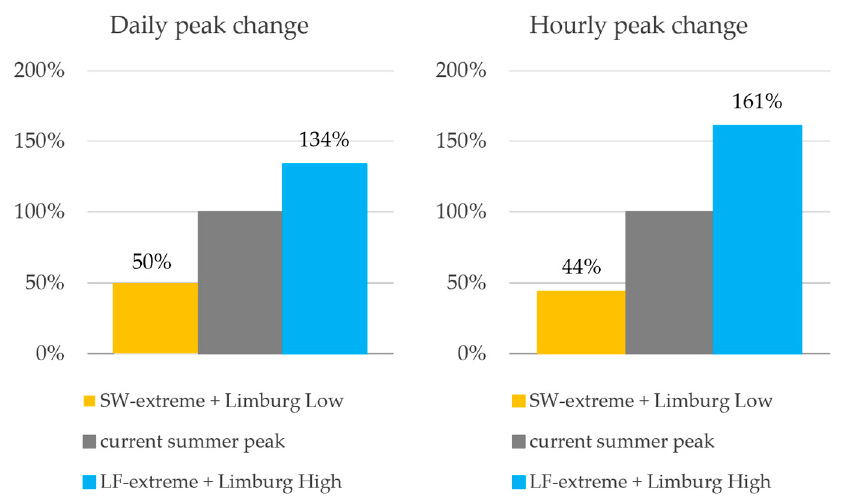
Figure 8. Change in summer day peak ( left ) and hour peak ( right ) in relation to current peak demands (100%) in Limburg.